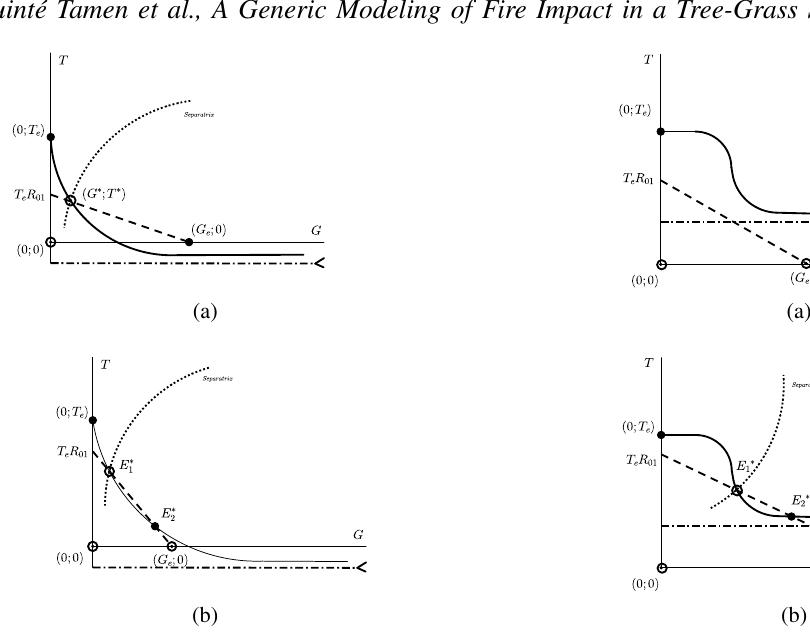
Fig. 5: Equilibria and their properties when R 01 < 1 and ω ( G e ) R 10 > 1 . Same as in Fig 2 , In (a), there is no coexistence and only woodland equilibrium is GAS. In (b), there are two feasible internal equilibria. A separatrix divides the plane into two basins of attraction; one to the stable woodland equilibrium; and one to the lower internal equilibrium